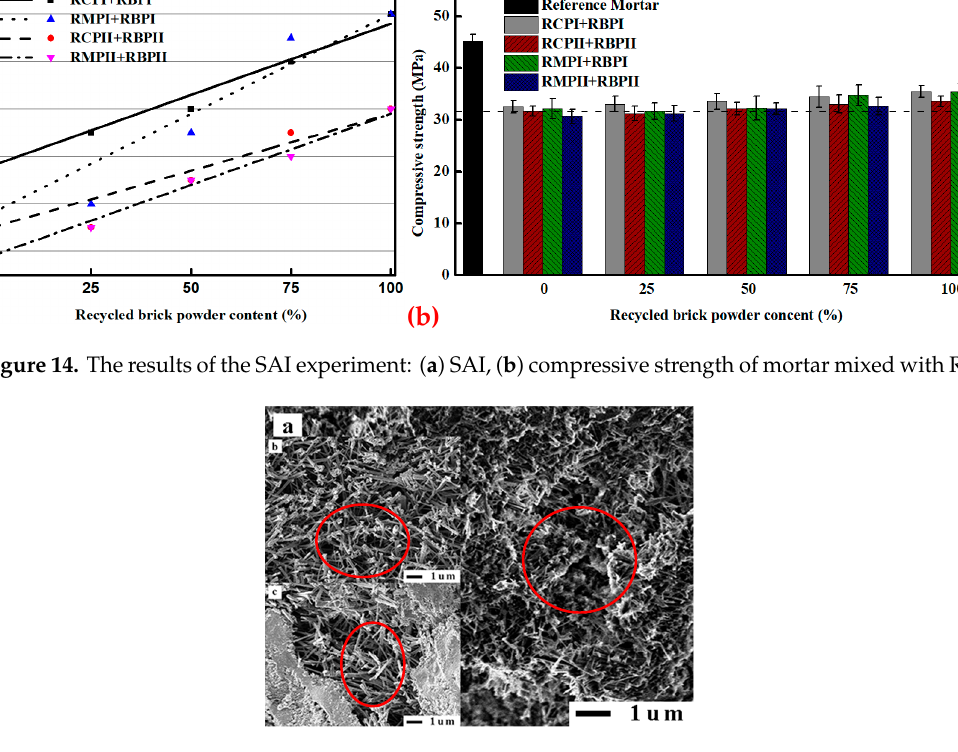
Figure 15. SEM morphology of pore structures of mortar mixed with RP: ( a ) RBP, ( b ) RMP, ( c ) RCP.